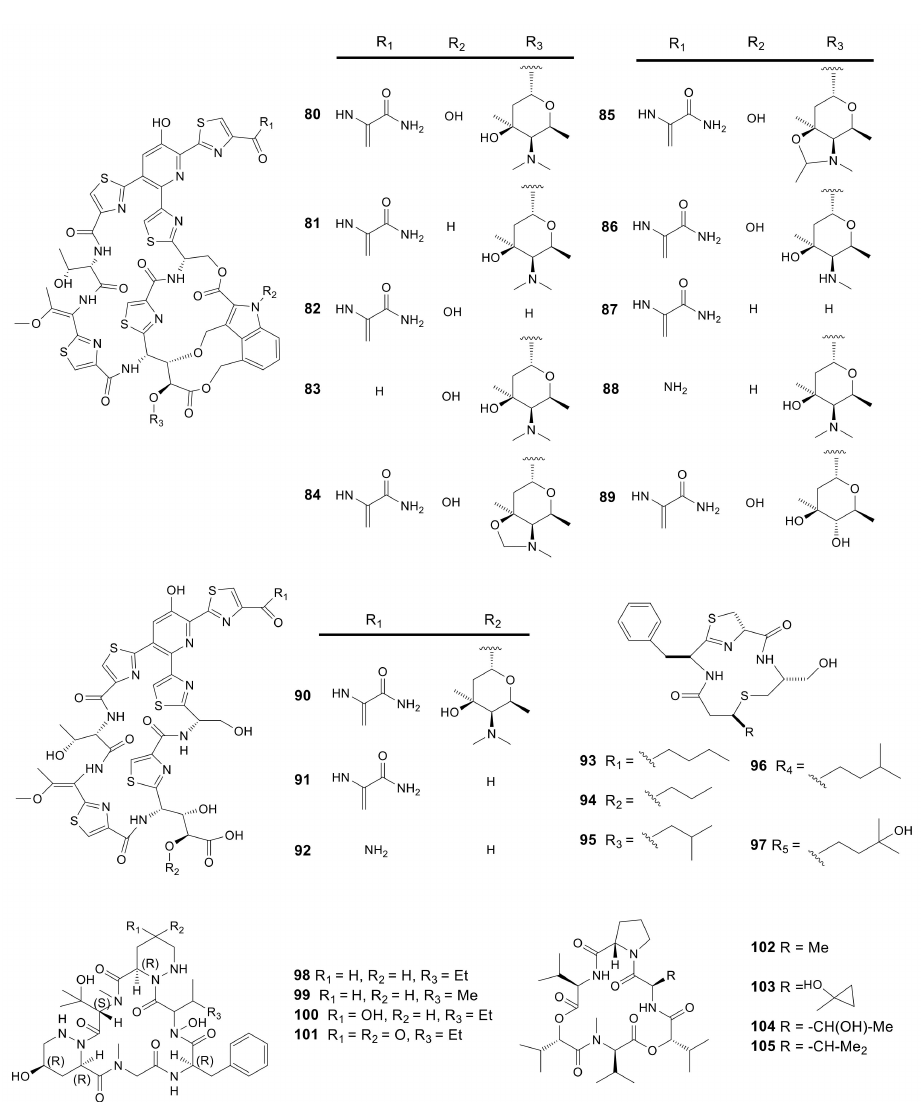
Figure 4. Structures of thiazolyl peptides ( 80 – 97 ) and cyclic peptides ( 98 – 105 ) from Amycolatopsis